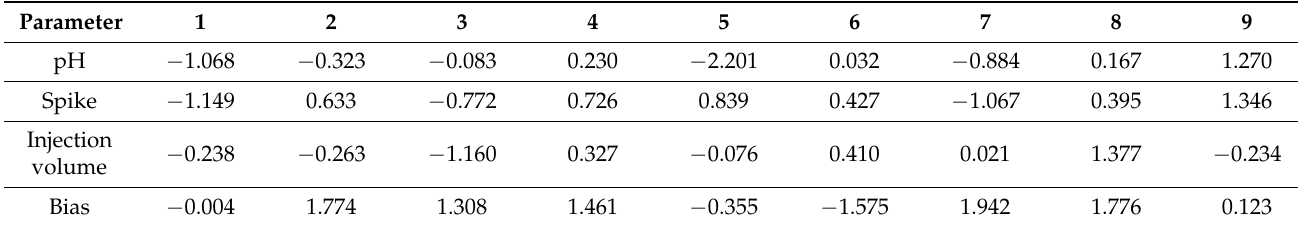
Table 5. The weight coefficients and biases W 1 and B 1 .